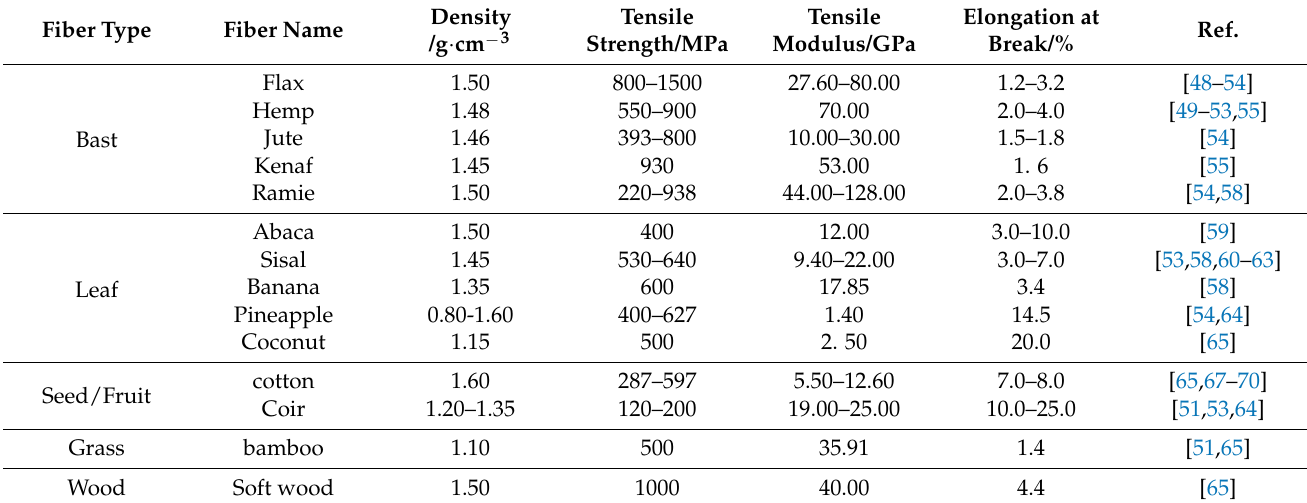
Figure 2. Basic structure of PF [42]. Table 1. Mechanical properties of typical PFs [48-70].